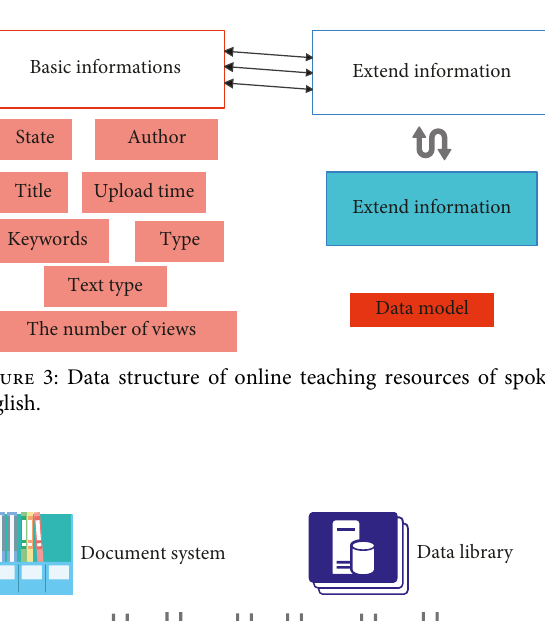
Figure 5: Entity E-R diagram of online teaching resources of spoken English.